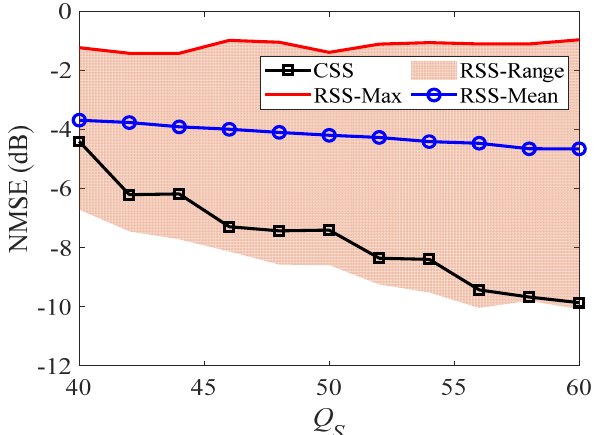
Figure 35. NMSEs of the real target images obtained under RSS and CSS against the numbers of selected frequencies (sub-pulses).